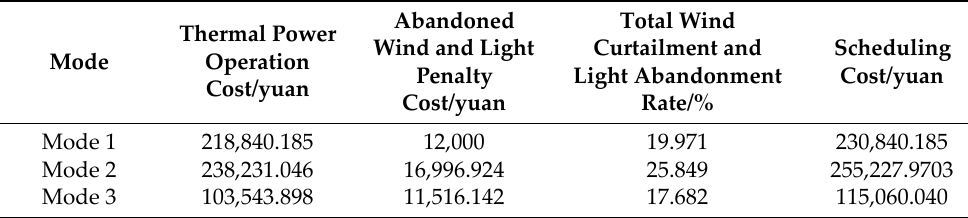
Table 5. Comparison of the optimization parameters under different scheduling